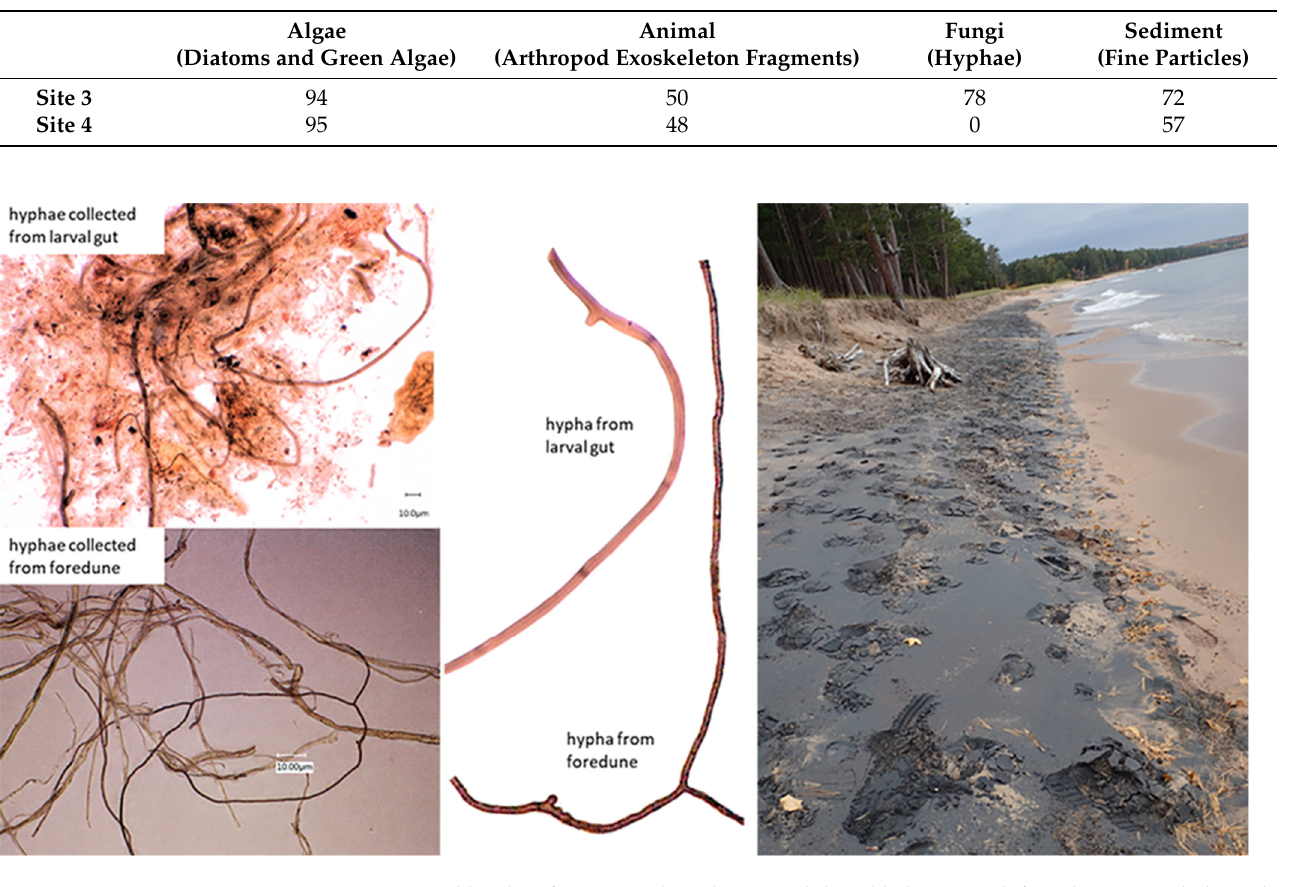
Figure 9. Fungal hyphae from Site 3 larval guts and their likely origin; left and center: side-by-side comparisons of fungal hyphae from the gut contents of a late-instar larval H. alternans and hyphae from the eroding face of a beach dune at Site 3; Right: beach at Site 3 facing north; the H. alternans habitat from which specimens were collected lies just to the south of this position. Eroding dune faces are visible at the beach–forest transition on the upper right. Dune grass stems, roots, and associated fungal hyphae are concentrated along the swash line on the lower right. The black sediment is magnetite (Fe 3 O 4 ) ground from bedrock by Pleistocene glacial ice and deposited at the high-water mark during the storm surge that eroded and carried the dune grass material into the surf zone.